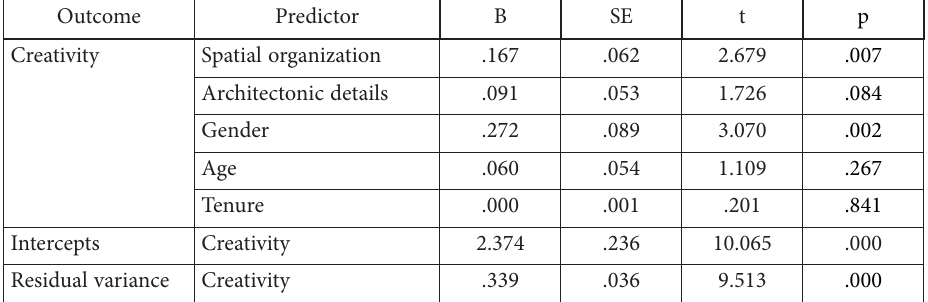
Table 2. Direct effects on creativity (source: created by authors) Outcome Predictor B SE t p Creativity Spatial